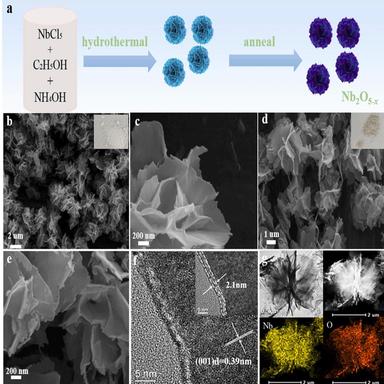
(a) Schematic illustrating of the fabrication route of Nb2O5-x, SEM image of (b, c) Nb2O5, (d, e) Nb2O5-x, (f) high-resolution TEM image of Nb2O5-x, and (g) the corresponding elemental mapping images of Nb2O5-x.